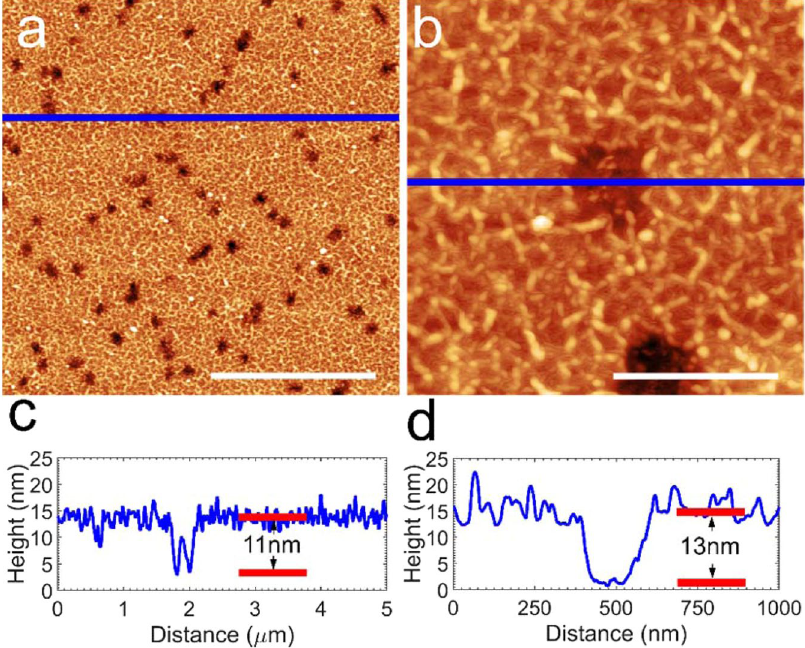
Figure 4. ( a ) AFM image of carbon deposited on sapphire after growth at 1400 °C for 5 h using the atomic carbon source. Scale bar: 2 µ m. The surface exhibits a series of pits caused by atomic carbon etching. ( b ) Zoom-in image of the area shown in ( a ). Scale bar: 400 nm. ( c ) Line profile taken across the region indicated by the blue line in ( a ). ( d ) Line profile taken across the region indicated by the blue line in ( b